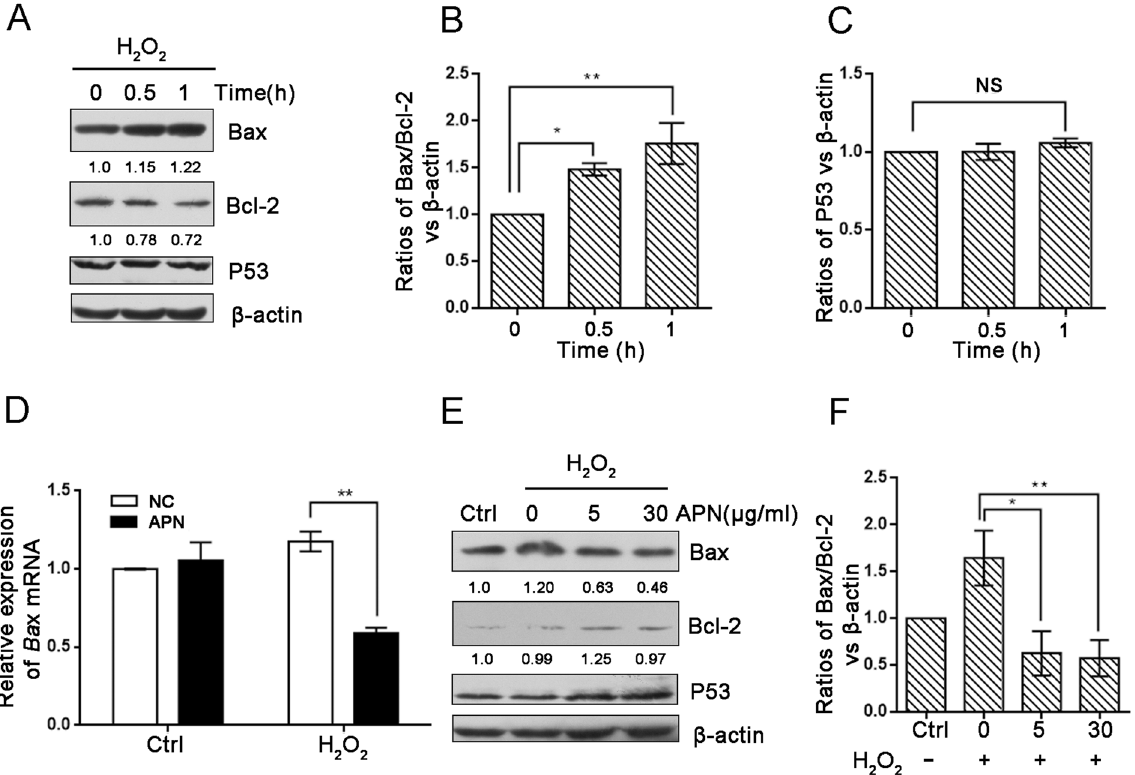
Figure 6. APN inhibits H 2 O 2 -induced apoptosis. ( A ) C2C12 cells were treated with 5 mM H 2 O 2 for the indicated periods. Samples were collected for western blotting to analyze the expression levels of Bax, Bcl–2, P53 and β -actin. ( B , C ) The densitometric ratios of Bax, Bcl-2 and P53 were quantified using Image J software. The analysis of the (Bax/Bcl-2)/ β -actin and P53/ β -actin ratios from the immunoblots is shown (data from three independent experiments). ( D ) The relative expression of Bax in C2C12 cells pretreated or not with 30 μ g/mL APN followed by treatment with 5 mM H 2 O 2 for 1 h. ( E ) C2C12 cells pretreated or not with various concentrations of APN followed by treatment with 5 mM H 2 O 2 for 1 h. Western blotting was performed to analyze the levels of Bax, Bcl-2, P53 and β -actin. ( F ) Image J densitometric analysis of the (Bax/Bcl-2)/ β -actin ratios from the immunoblots is shown (data from three independent experiments) ( * p < 0.05, ** p <